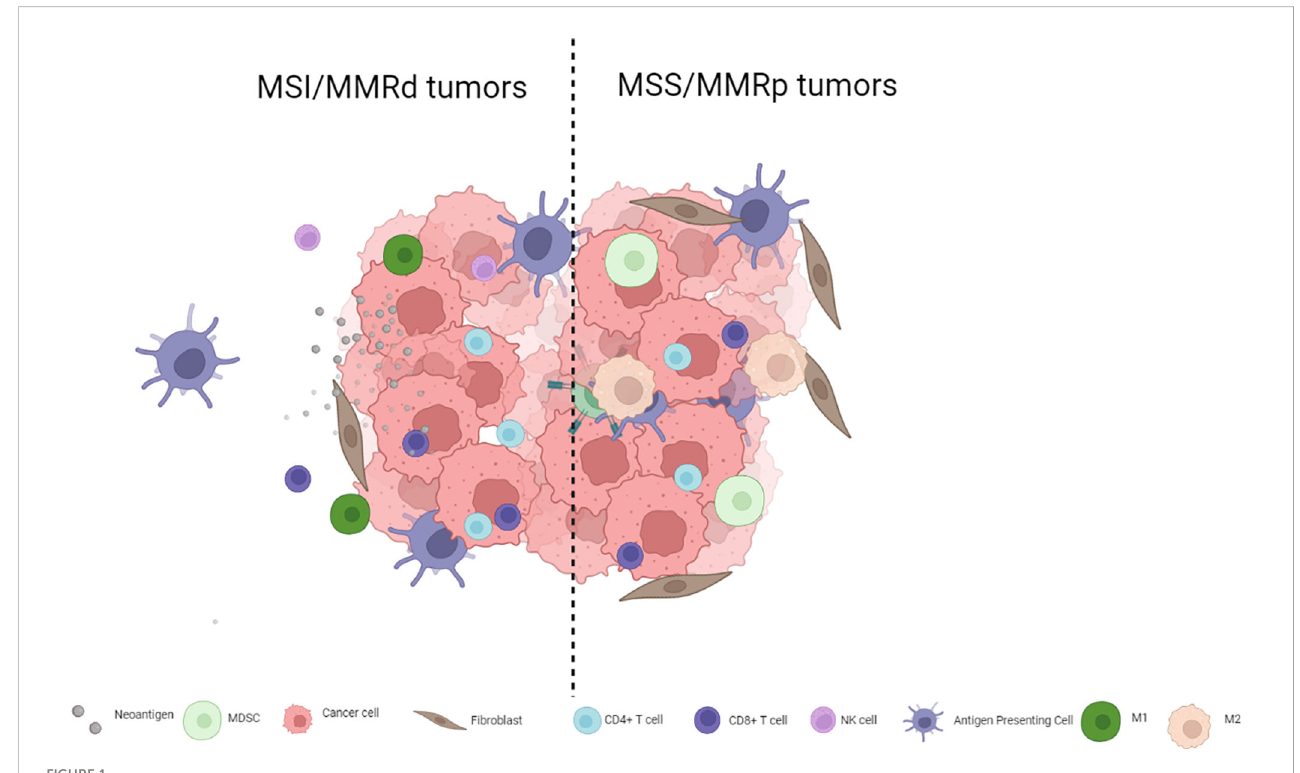
FIGURE 1 Key differences in immune cell in fi ltration for MSS and MSI